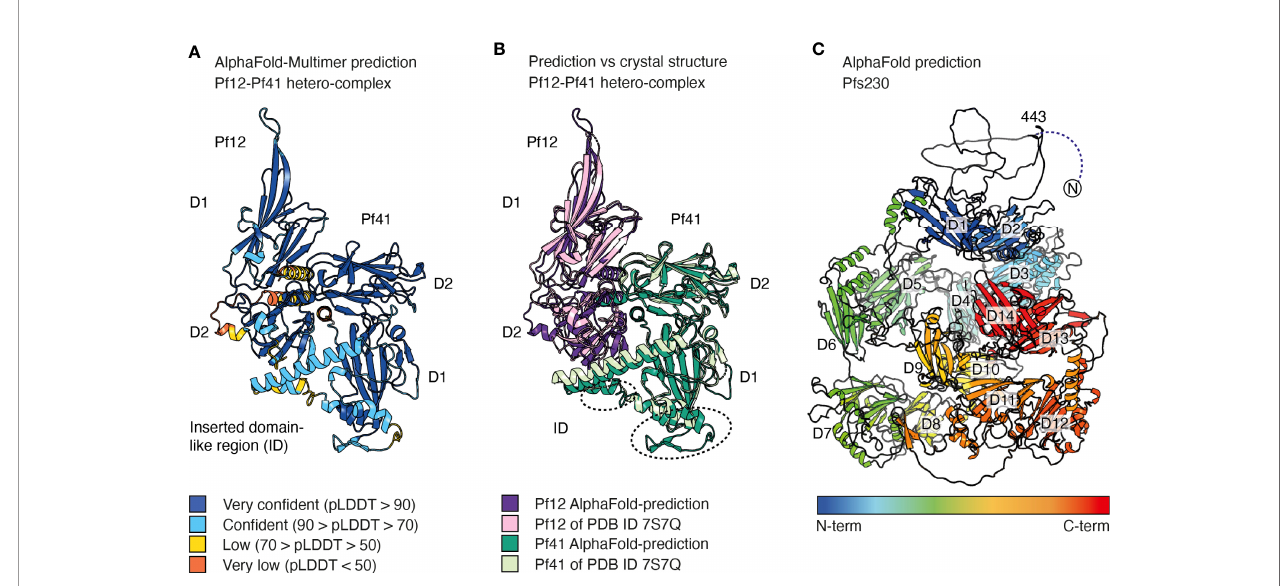
FIGURE 4 | AlphaFold predictions of selected 6-cysteine proteins. (A) AlphaFold-Multimer prediction of the hetero-dimeric complex of Pf12 and Pf41. Amino acids are colored based on their per-residue con fi dence score (pLDDT), which values can be between 0 and 100. Low values indicate low con fi dence and high numbers indicate very con fi dent predictions. Amino acids are either colored orange (pDLLT <50), yellow (70> pDLLT >50), light blue (50< pDLLT >70), or dark blue (pDLLT >90). Regions with pLDDT <50 may be unstructured in isolation. (B) Alignment of the AlphaFold prediction (dark purple and dark green) of the Pf12-Pf41 hetero-dimeric complex with the Pf12- Pf41 crystal structure (light purple and light green, PDB ID 7S7Q). Regions of the Pf41 ID which are not de fi ned in the crystal structure are indicated by dotted circles. (C) AlphaFold prediction of Pfs230 colored from blue to red from N- to C-terminus. The N-terminal residues 1-575 have low pDLLT values of <50. Residues 1-442 are not shown for clarity of the image. The 14 6-cysteine domains are indicated from D1-D14. AlphaFold models were generated at WEHI (Australia) using the AlphaFold